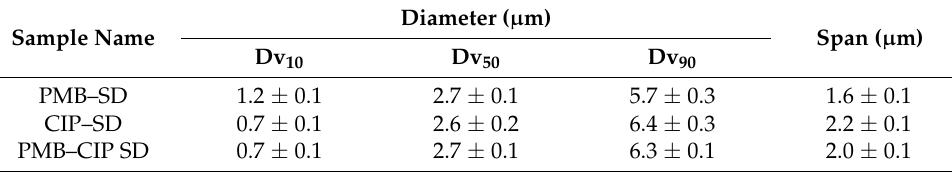
Table 4. Particle sizes of dry powder